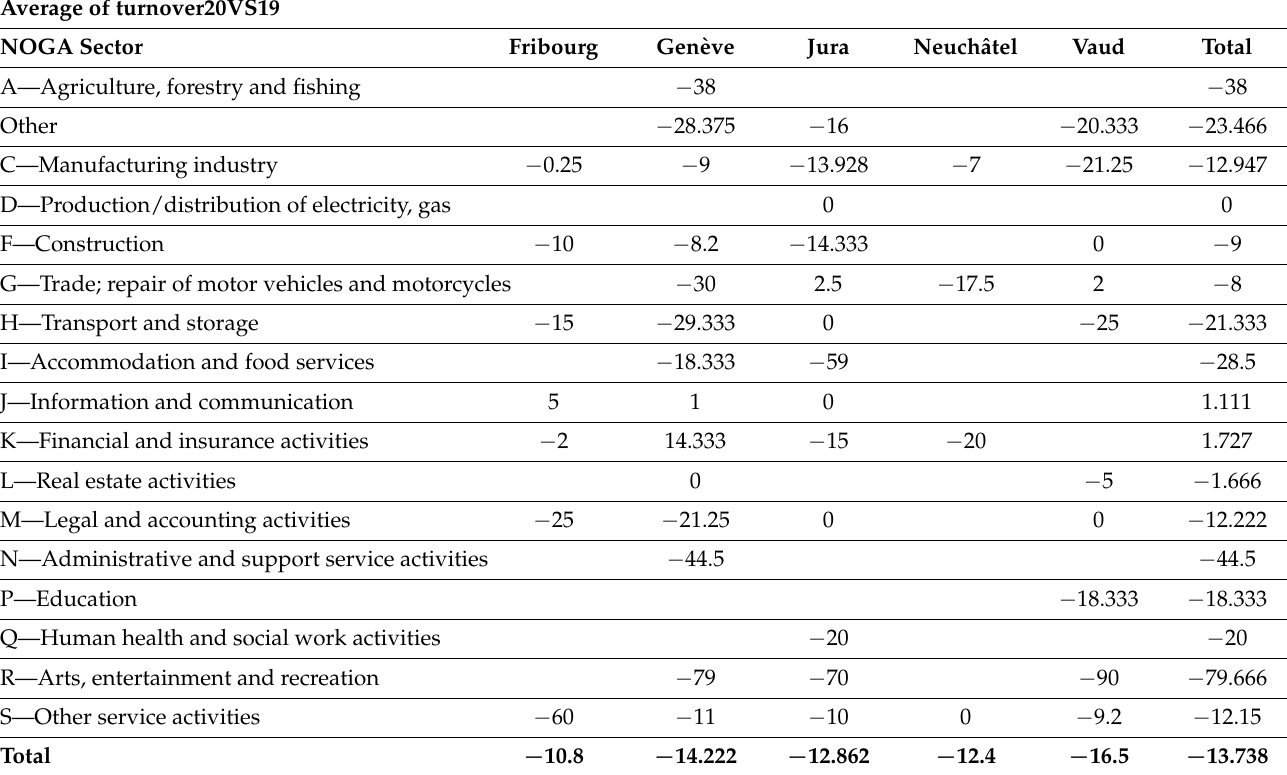
Table 4. Average values for turnover 2020 % by canton and economic sector.